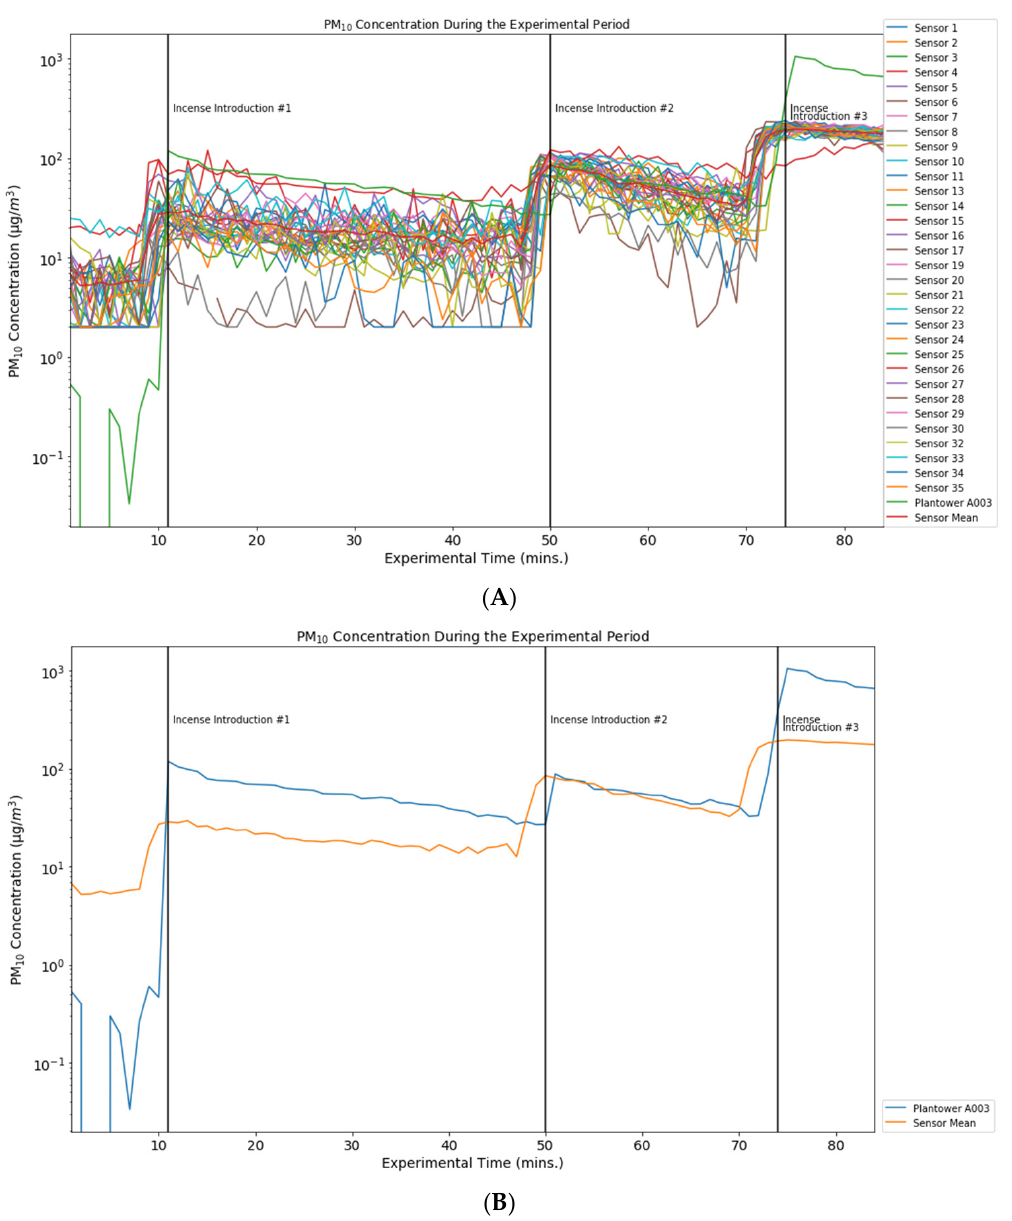
Figure 2. Caption: PM 10 Concentration During the Experiemental Period Featuring Data from 32 Flow Sensors Individually ( A ) and in Aggregate ( B ) vs. Plantower A003.